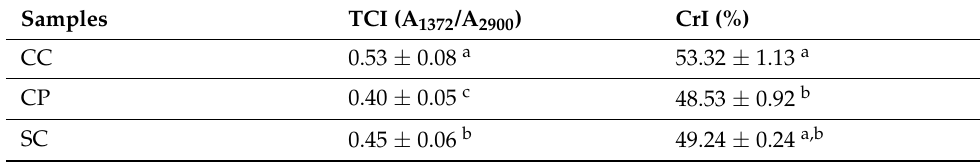
Table 1. The total crystalline index (TCI) from FTIR parameters for crystallinity assessment and the crystallinity index (CrI%) from XRD data of adsorbents; including corn cob (CC), cornstalk piths (CP) and sugarcane bagasse (SC). Means with different letters ( a , b , c ) within each column indicate statistically significant differences between the samples after Duncan’s analysis ( p < 0.05).